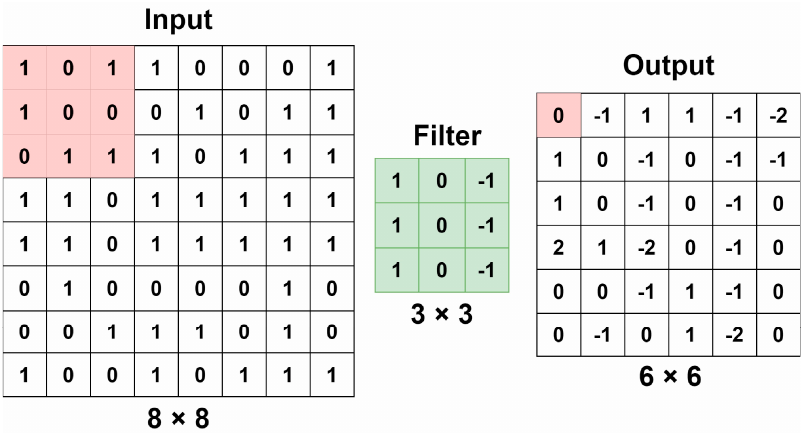
Figure 2. Convolution layer.